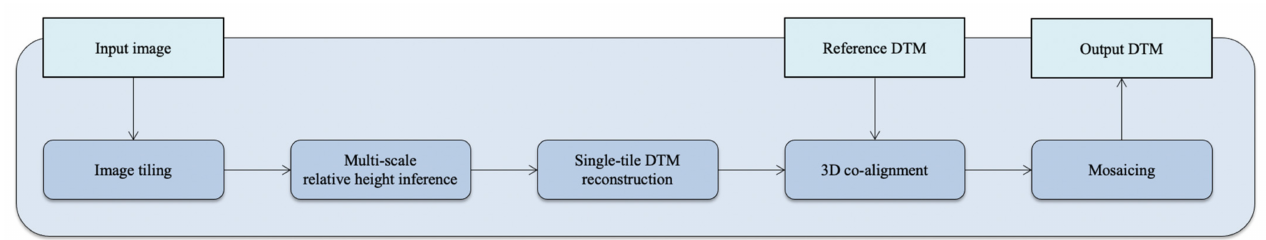
Figure 3. Simplified flow diagram of the MADNet 1.0 single-image DTM estimation system described in [6]. N.B. lighter coloured boxes represent the inputs and/or